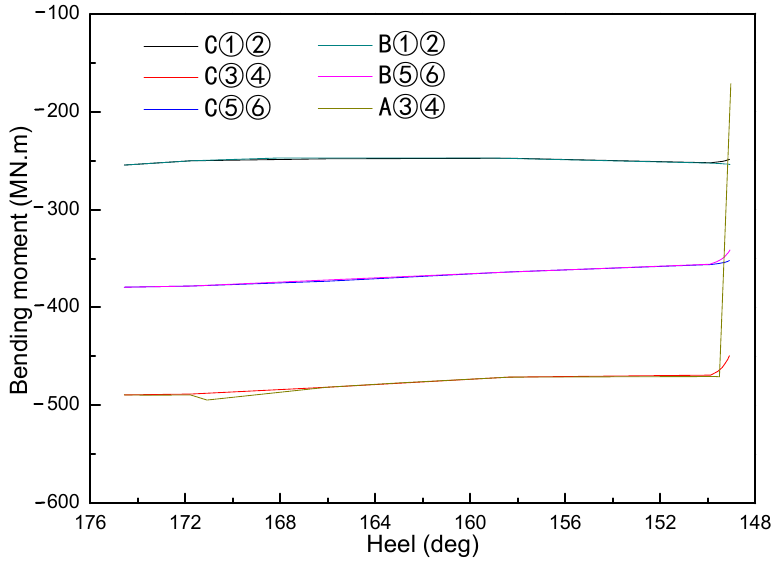
Figure 8. Variation of bending moment under case Ⅱ .